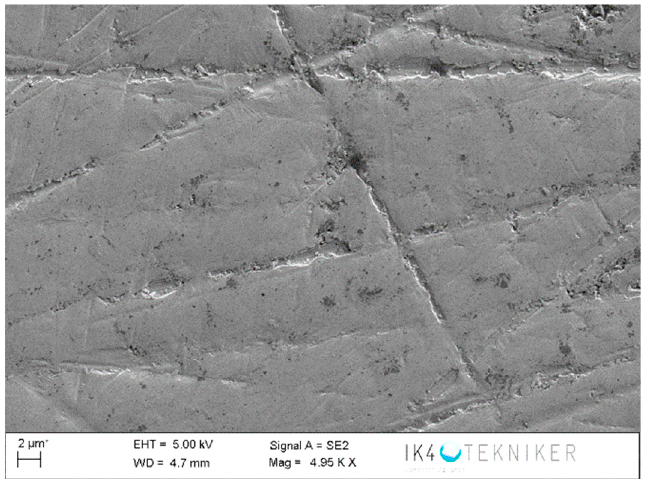
Figure 20. SEM image of a non-tested area of the disc. Polymers 2020 , 12 , x FOR PEER REVIEW